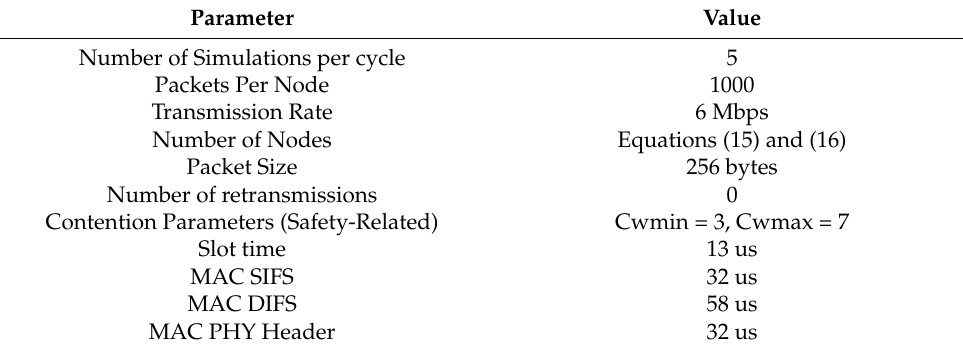
Table 6. Simulation parameters.